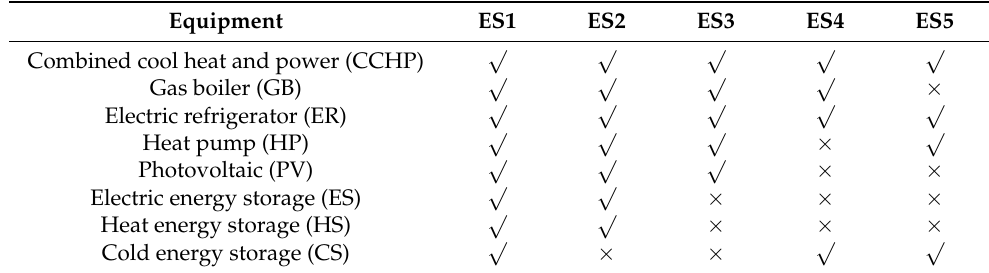
Table 2. Energy station equipment